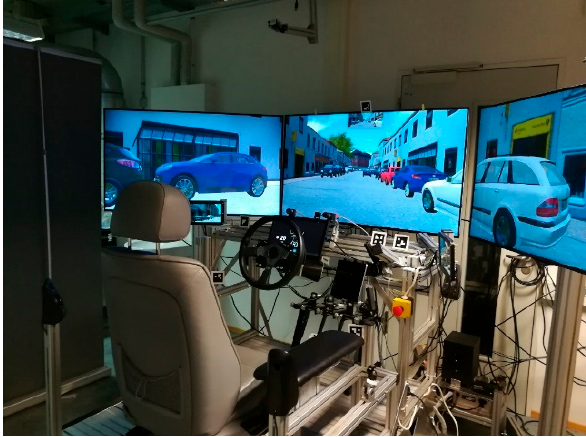
Figure 1. Dynamic mock-up used in the present study.